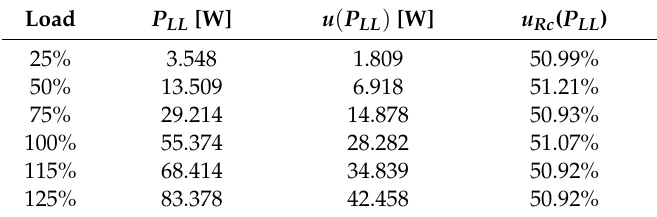
Table 4. Experimental results—additional losses with uncertainties according to